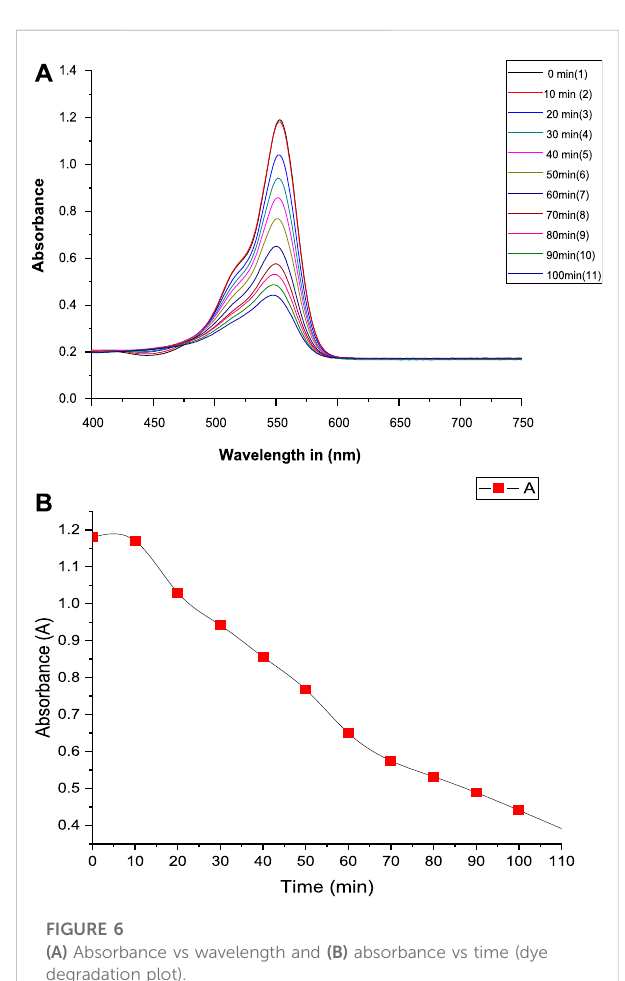
FIGURE 6 (A) Absorbance vs wavelength and (B) absorbance vs time (dye degradation ZnO e − + h + (cid:1)